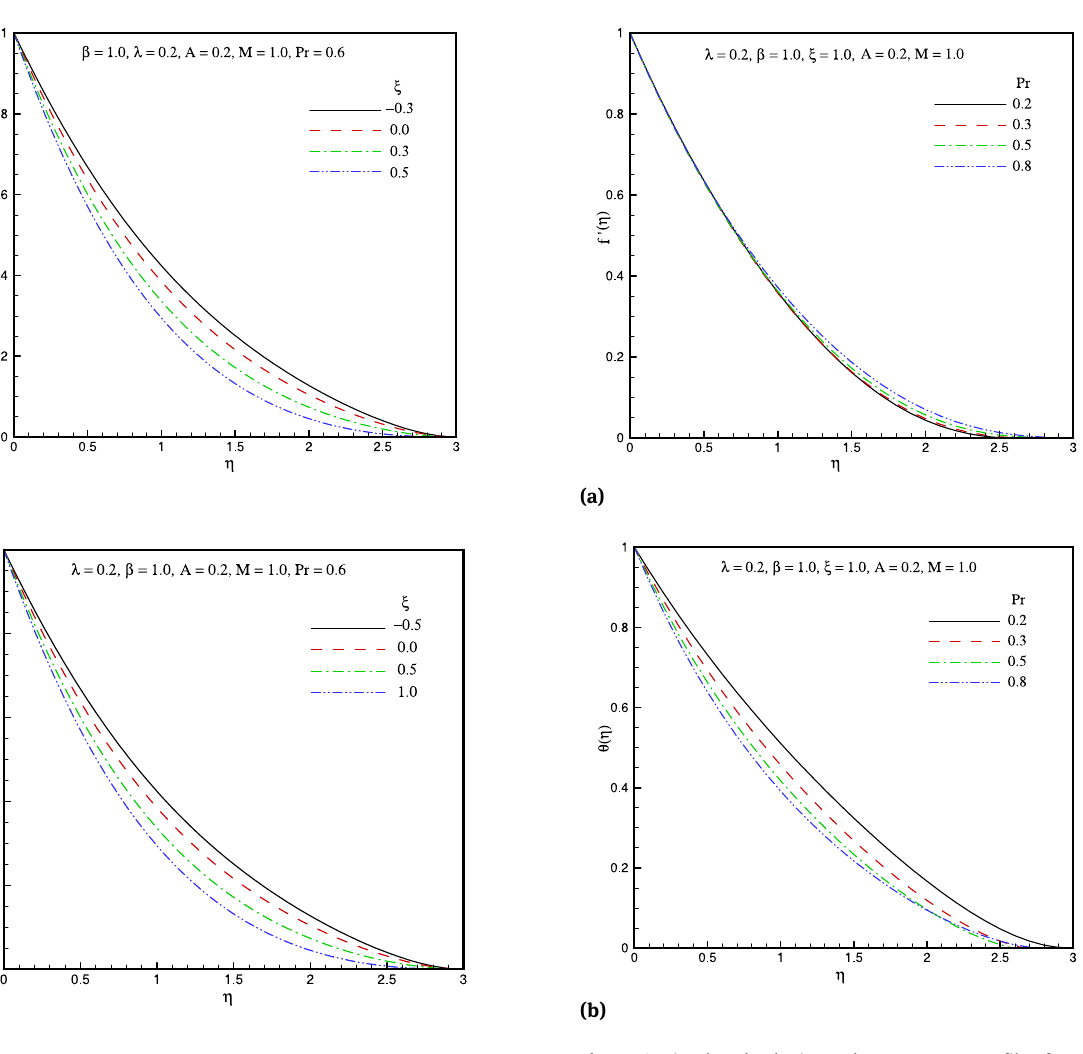
ing equations is presented to reveal the validity and ease of this method. For elucidating the correctness of described method, a numerical method via the MATLAB symbolic code ‘bvp4c’ was also used to solve the problems. Further comparison of present solutions with available existing literature is incorporated. The present calculations reveal that: